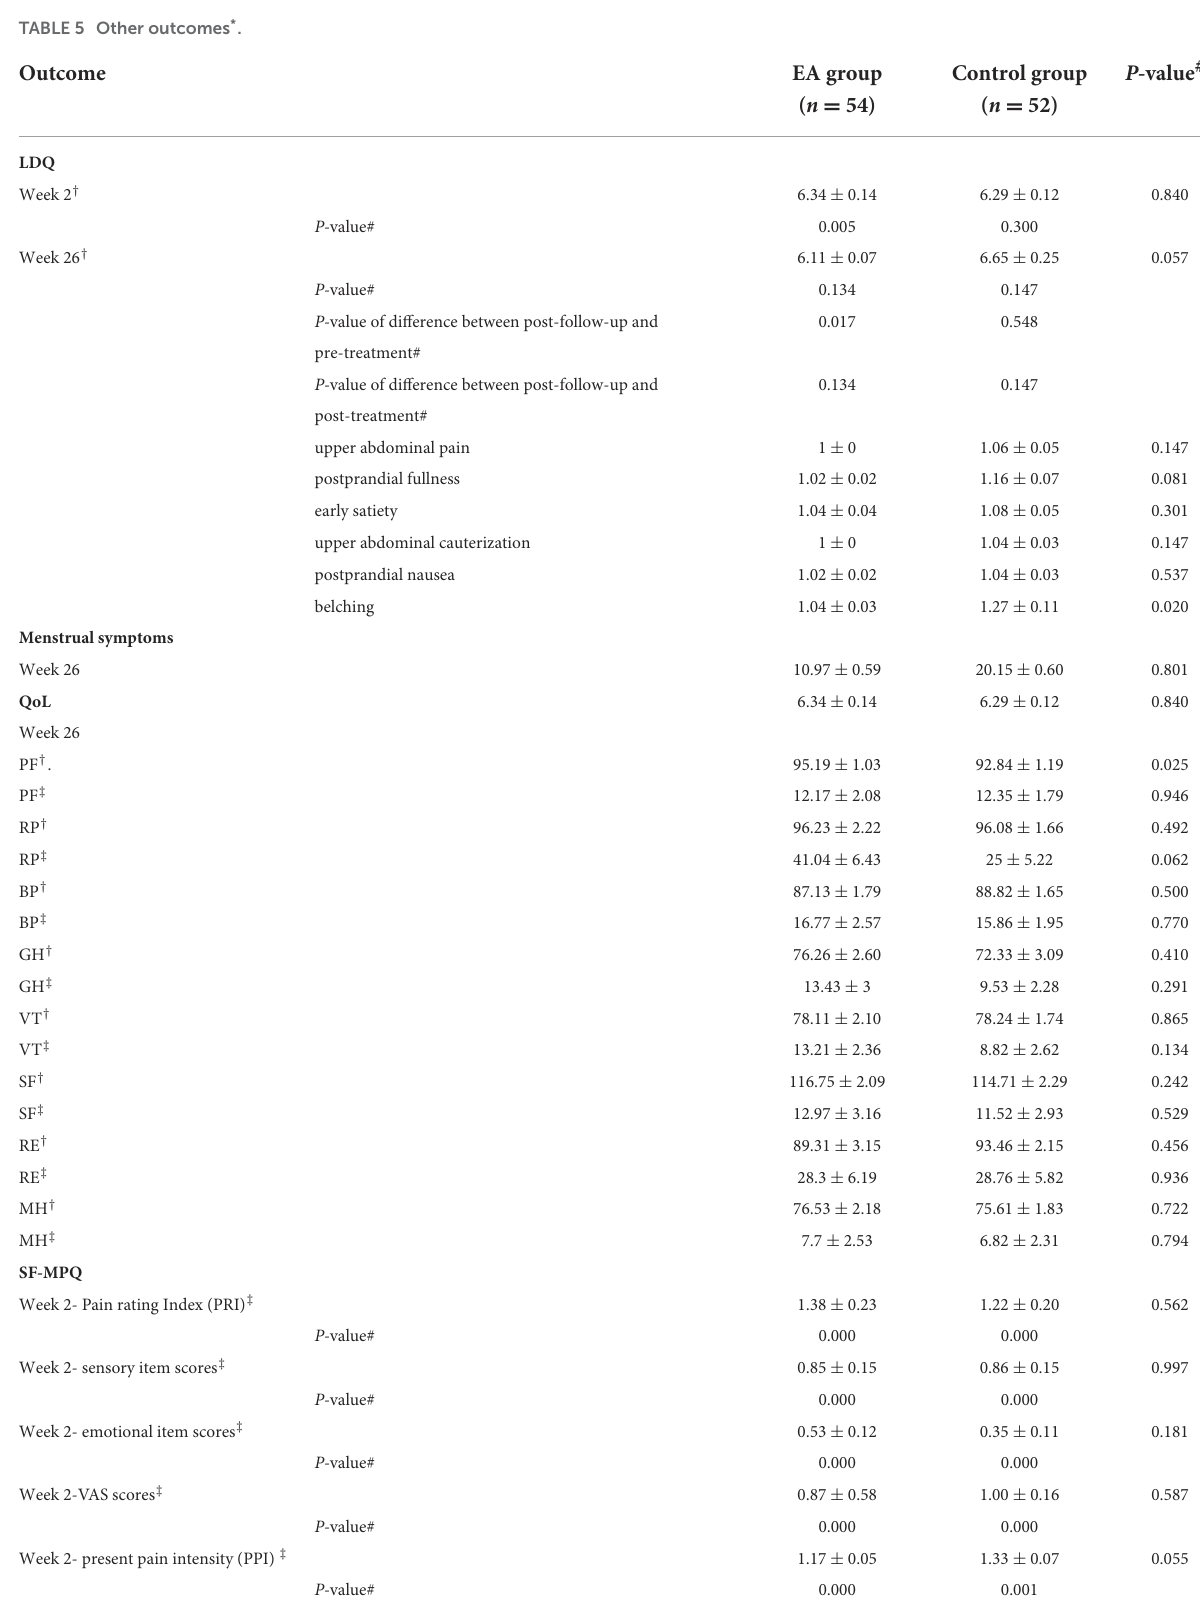
TABLE 5 Other outcomes *